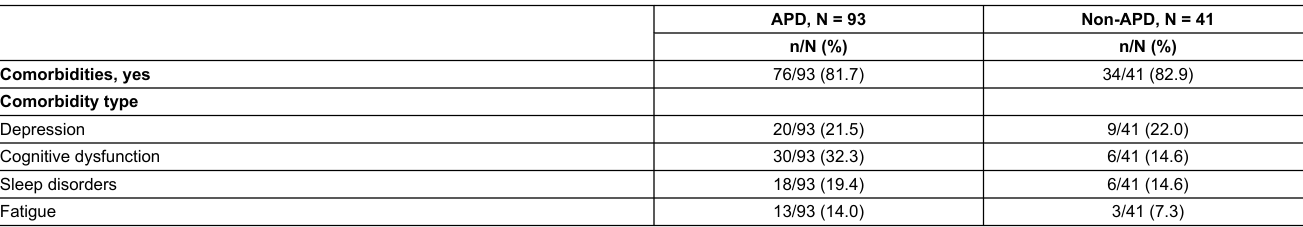
Table 3: Neuropsychiatric comorbidities of ADP and non-ADP based on physician’s